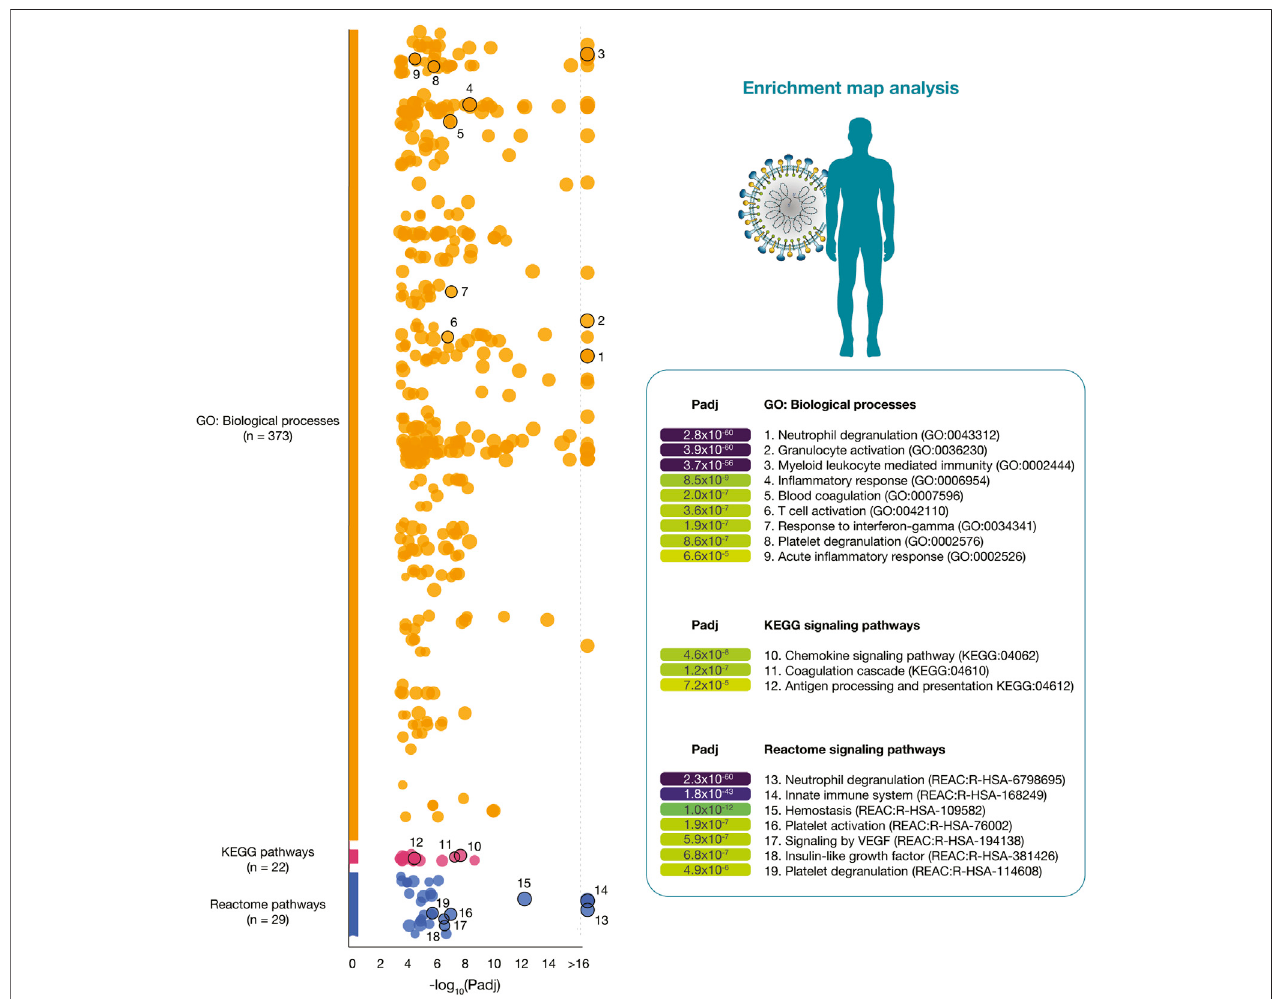
FIGURE 3 | Enrichment map analysis of the immune system PPi subnetwork. Signi fi cant GO: biological processes, KEGG signaling pathways, and Reactome signaling pathways.